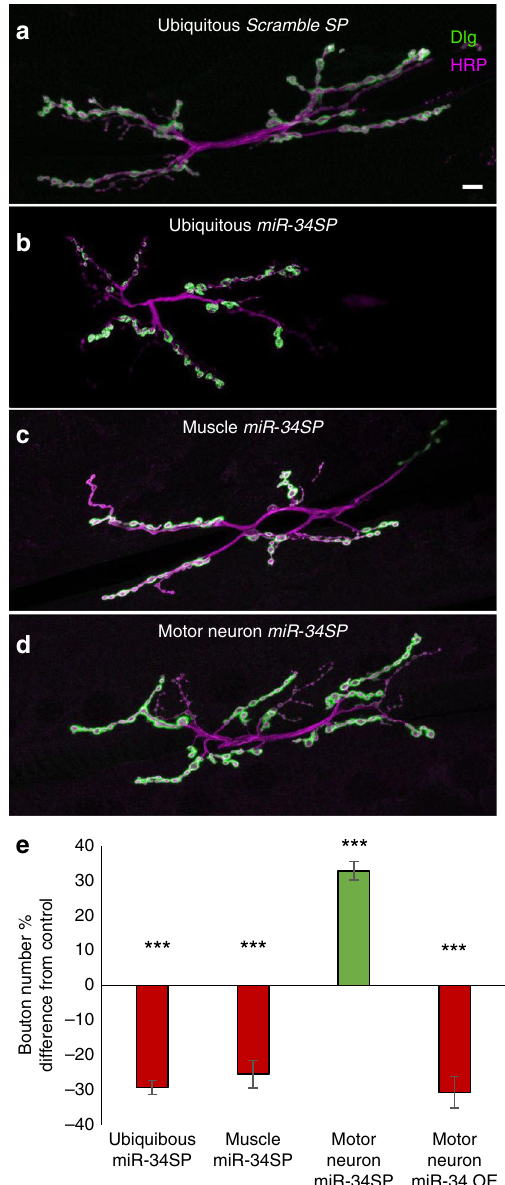
Fig. 3 Tissue-speci fi c function of miR-34 for bouton addition is revealed by conditional inhibition. a – d Scanning confocal images of M6/7NMJ (segment A2) stained for the presynaptic membrane (HRP, magenta), and postsynaptic (Dlg, green). a ubiquitous Scramble-SP expression with tubulin-GAL4 driver, b ubiquitous GenII miR-34SP expression with tubulin-GAL4 driver, c muscle-speci fi c GenII miR-34SP expression with DMef2-GAL4 driver, d motor neuron-speci fi c GenII miR-34SP expression with OK6-GAL4 . Scale bar (10 mm) applies to a – d . e Quanti fi cation of bouton number changes relative to Scramble-SP crossed with appropriate driver control for the GenIII miR-34SP competitive inhibitor expressed under control of tubulin-GAL4 ( n = 20 for ScrambleSP and miR-SP ), DMef2-GAL4 ( n = 21 for ScrambleSP and n = 21 for miR-SP ), or OK6-GAL4 ( n = 20 for ScrambleSP and n = 21 for miR-SP ), or the UAS- miR-34( + ) overexpressor expressed under control of OK6-GAL4 ( n = 20 for OE and control). Signi fi cant decrease in bouton number (red bars) or increase in bouton number (green bar) are shown. Error bars indicate ±SEM (*** p -value ≤ 0.001). Source data are provided as a Source Data fi